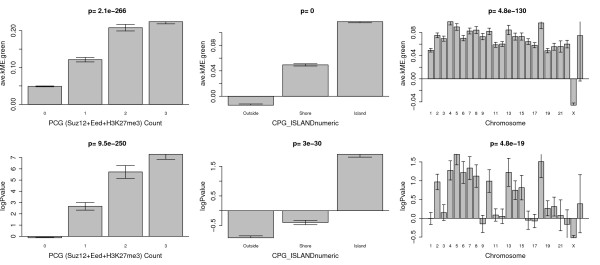
Relating age relationships to chromosomal properties. The bar plots in the top row relate average module membership in the aging module (average kME with respect to the green module) to Polycomb group (PCG) occupancy count, CpG island status, and chromosomal location, respectively. The bottom row shows the corresponding bar plots involving the (signed) logarithm of the meta analysis P-value. A positive (negative) log P-value indicates a positive (negative) age correlation of the CpG site. Both age association measures lead to the following results. First, the higher the PCG occupancy count, the stronger the age association. Second, CpG sites in CpG islands tend to have positive age correlations while those outside tend to have negative age correlations. Third, CpG sites on X chromosomes tend to have lower age correlations than those on other chromosomes. While both age association measures lead to similar conclusions, the results are more pronounced for the module membership measure (average kME), which suggests that this measure leads to more meaningful biological conclusions. Error bars indicate one standard error.